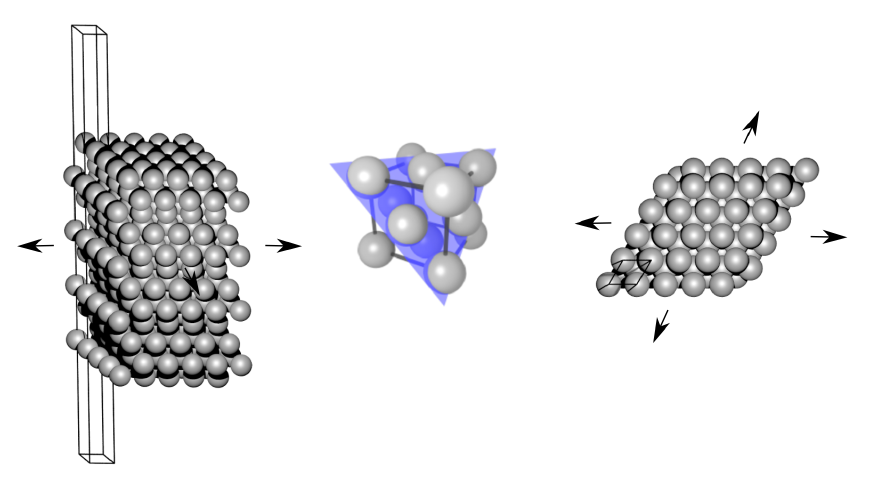
Figure 3. A schematic visualization of a computational cell, so-called slab, used for calculations of surface energy and surface stress in fcc-structure Ag (the visualization shows a 5 studied primitive cell within the surface plane, a side view on the left, and a top view on the right). The surface is formed by the (111) crystallographic plane (see it in the middle also visualized inside a bulk fcc structure elementary